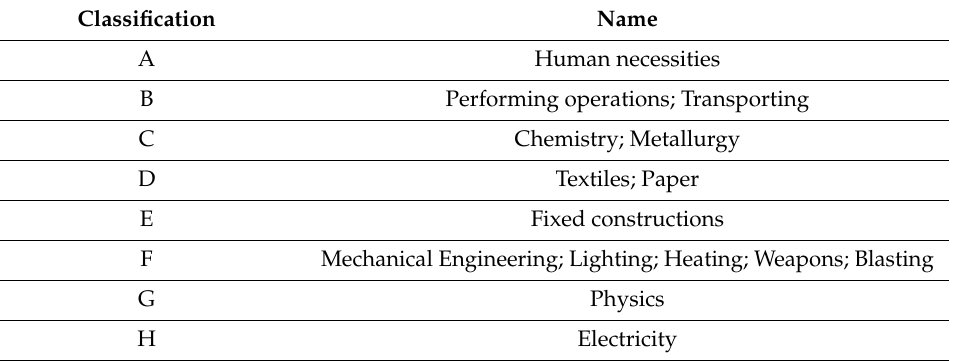
Table A1. IPC classification used in this